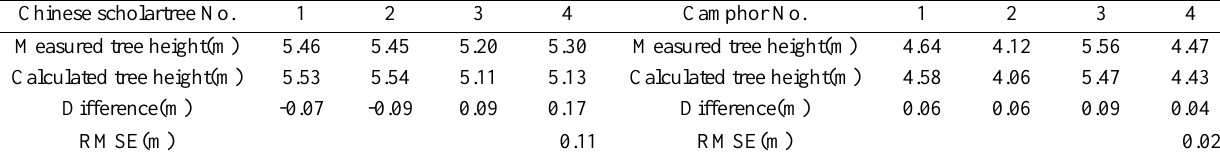
Table 1. Tree height calculation results